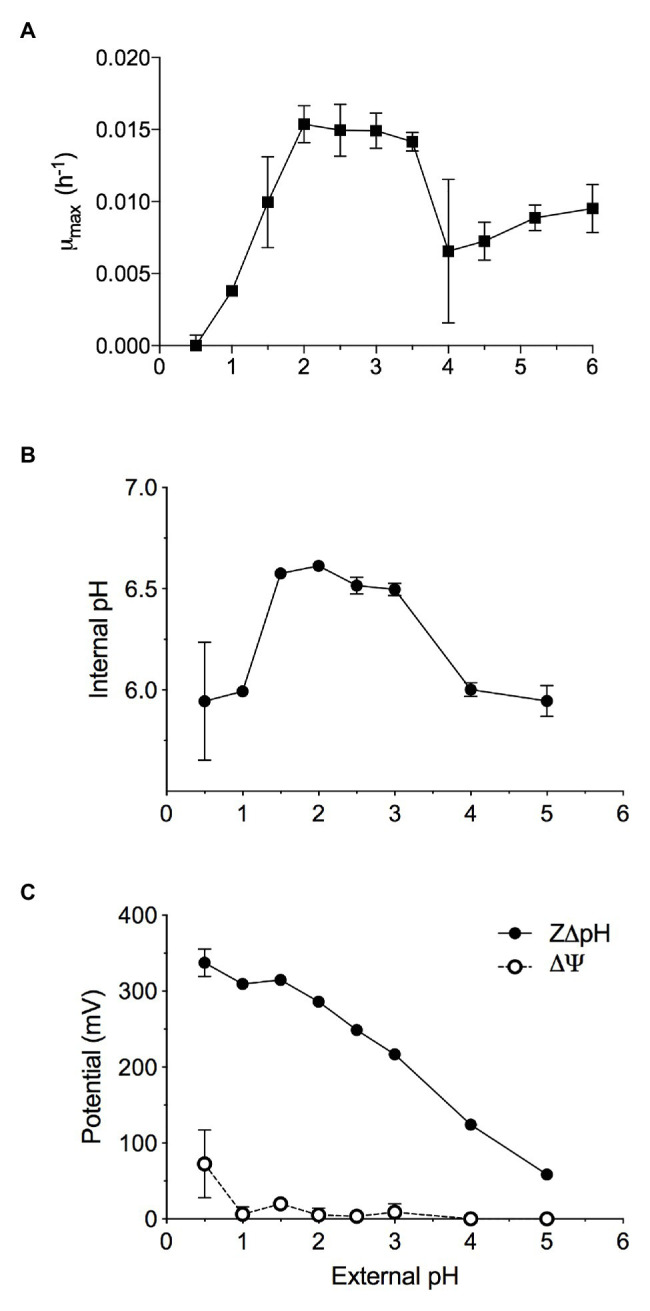
The maximal growth rate of methane-grown Methylacidiphilum sp. RTK17.1 in batch culture is highly dependent on maintaining pH homeostasis. Optimal growth was observed where extracellular 1.5 < pH < 4.0, resulting in the maintenance of an internal pH 6.55 ± 0.05. (A) Maximum specific growth rates observed in batch cultures of Methylacidiphilum sp. RTK17.1 (10% CH4 v/v in air) at 50°C in V4 medium at different pHs (range pH 0.5–6.0). (B) The corresponding internal pH and; (C) membrane potential (Δψ) and (Z∆pH) as a function of external pH are shown. Error bars represent the standard deviation of triplicate measurements.